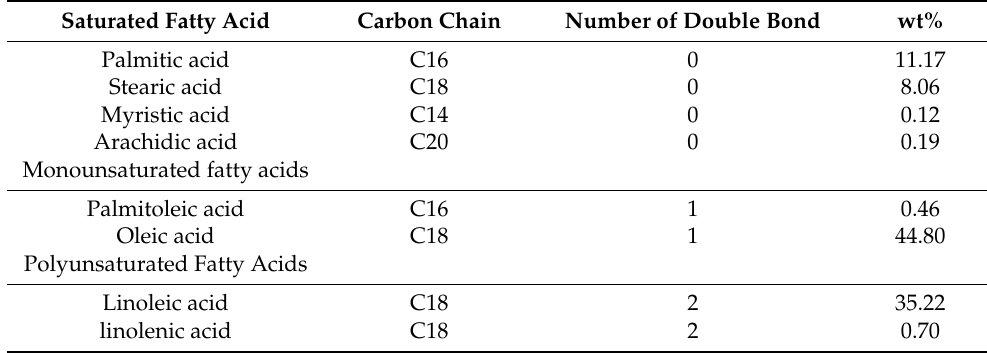
Table 4. Fatty acids of the crude JCLO (Tabasco,